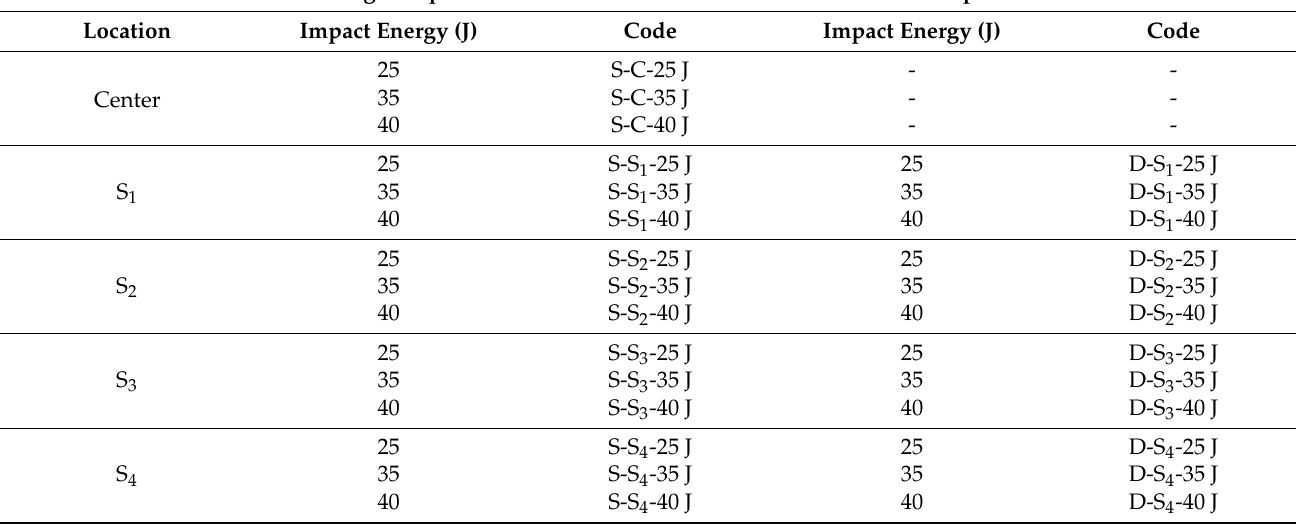
Table 2. Parametric study cases for different single low-velocity impact events at different locations, and for different multiple low-velocity impacts at different locations (for the double impacts, the notations only represent the results of the second impact since the first impact is equal to 40 J for all impact